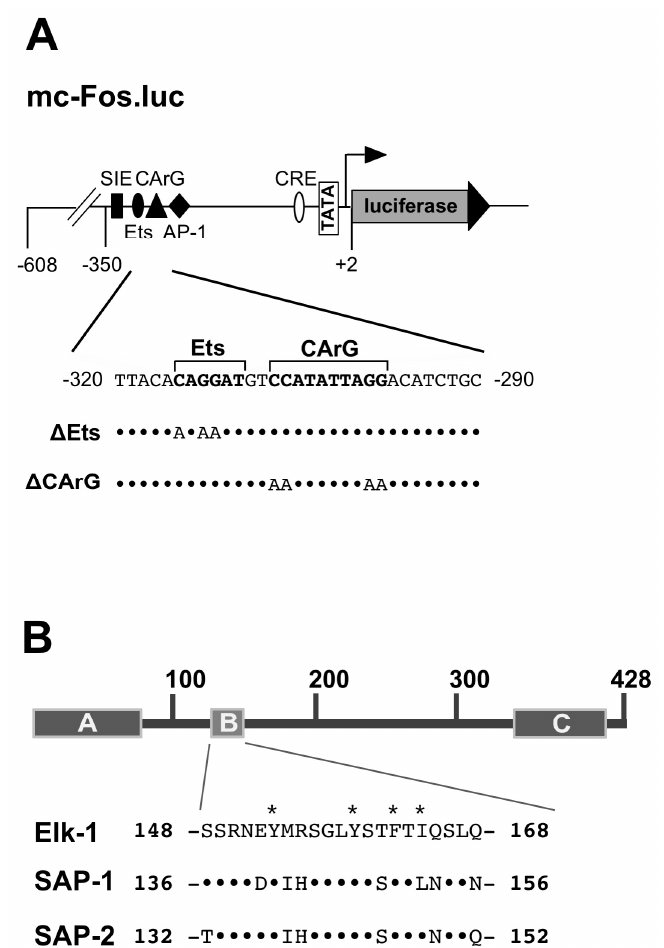
Figure 5. Role of DNA binding and protein–protein interaction to generate a functional ternary complex. ( A ) Sequence of the intact c-Fos promoter. The mutations to inactivate the DNA binding of either Elk-1 ( Δ Ets) or SRF ( Δ CArG) are indicated. ( B ) Sequence alignment of the B-box of the TCF proteins Elk-1, SAP-1 and SAP-2. Alanine scanning identified the importance of the Elk-1 residues Y153, Y159, F162 and I164 (indicated with stars), while an X-ray analysis of a SAP-1-SRF complex showed that the SAP-1 residues Y141, L246, F150 and L155 contribute to the SRF binding interface. Reproduced with modifications from Refs. [25,28] with permission from John Wiley and Sons, and Elsevier. The sequence information is derived from Ref. [7].